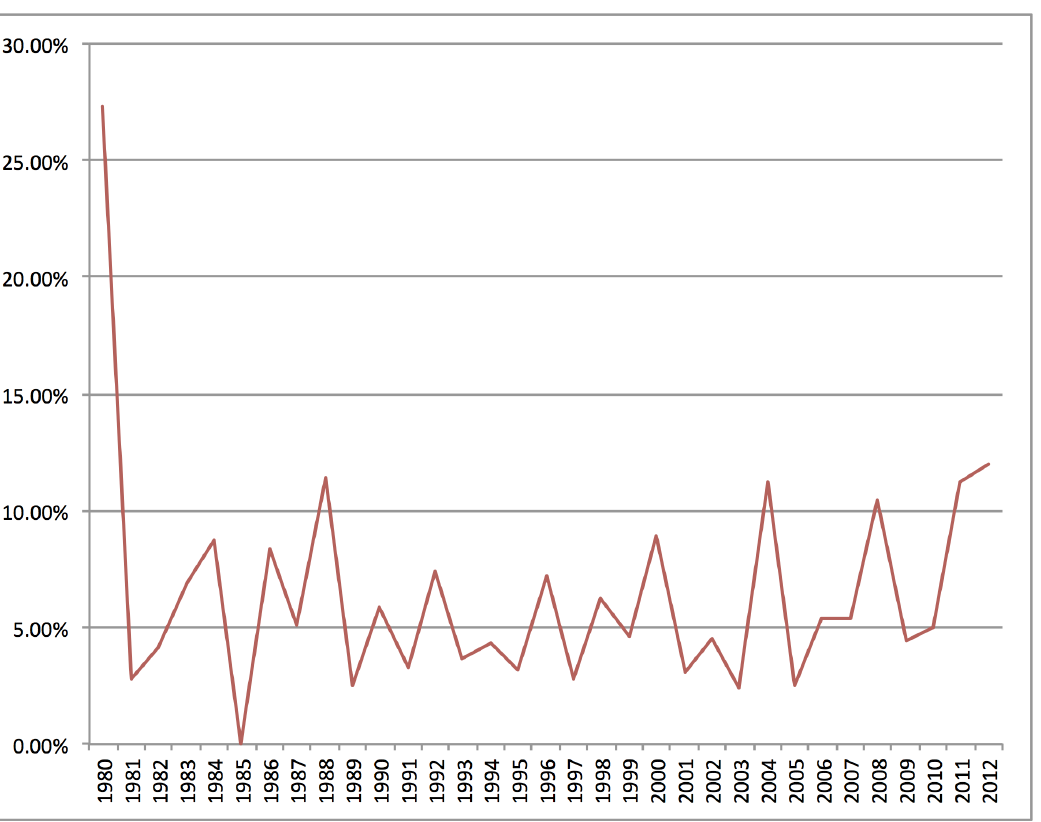
Figure 9. Prominence of presidentialpolitics in demarcation corpus over time. Percentage of documents in each year with at least 15% presidential politics content.